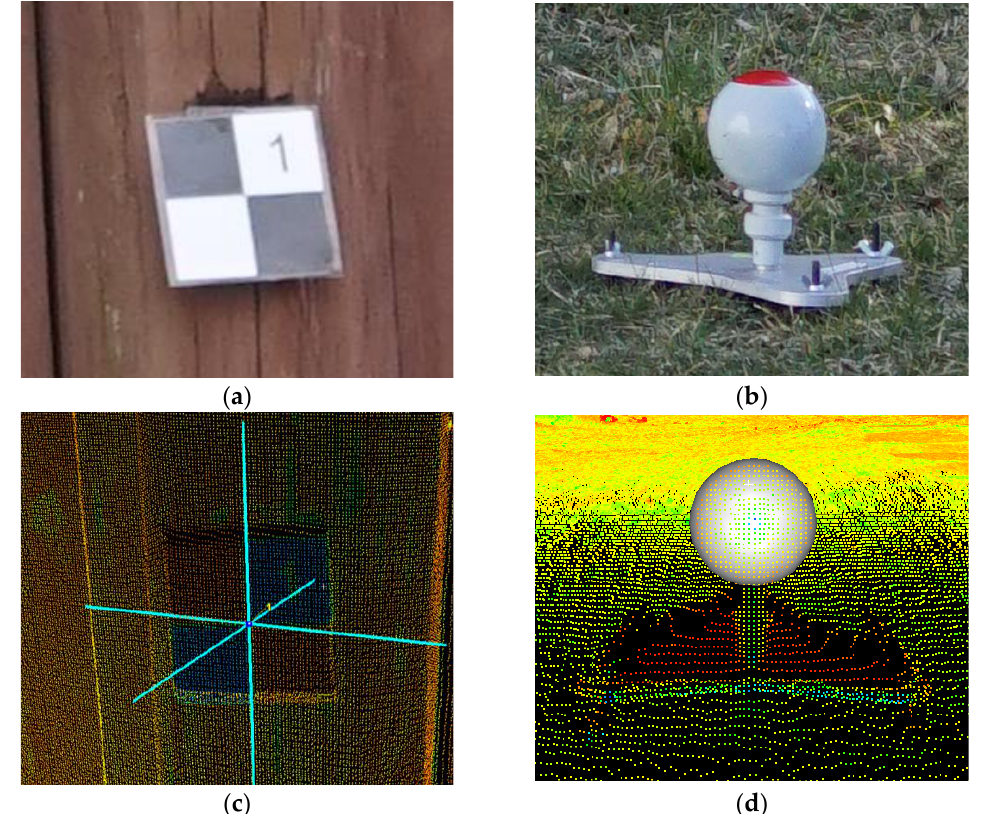
Figure 3. Georeference Control Points ( a ) Black and white target plate temporarily attached to the surface of the scanned chapel; ( b ) Reference ball stabilised in the test area; ( c ) Black and white target plate in model space; ( d ) Reference sphere in the model space.